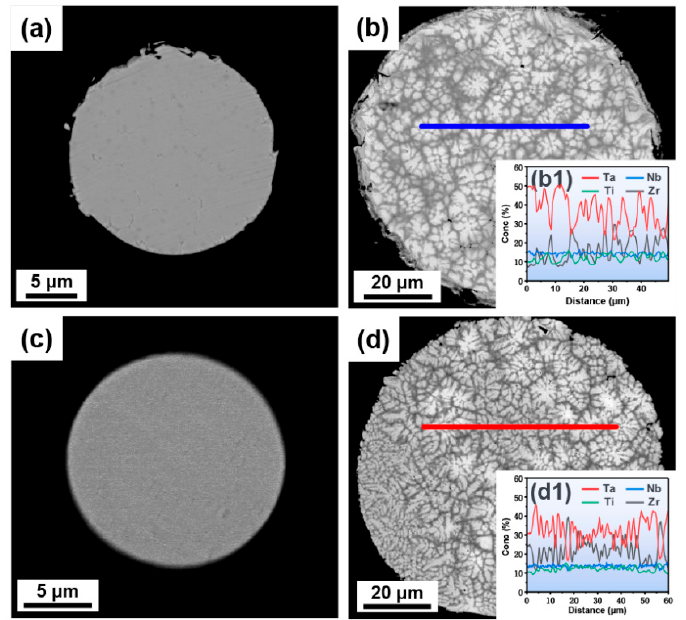
Figure 7. Cross-section microstructure of the ( a , b ) EIGAed and ( c , d ) PREPed TaNbTiZr RHEA pow- ders; ( b1 ) and ( d1 ) are the elemental line scanning of the marked regions in ( b ) and ( d ), respectively.